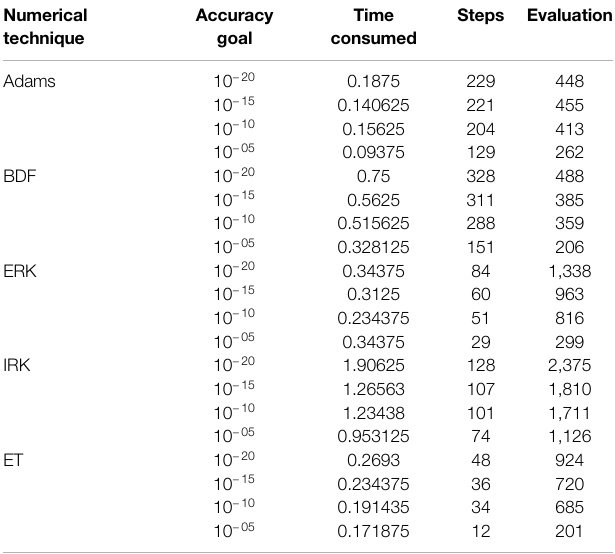
TABLE 7 | Comparison of numerical results of velocity for Adam ’ s method and